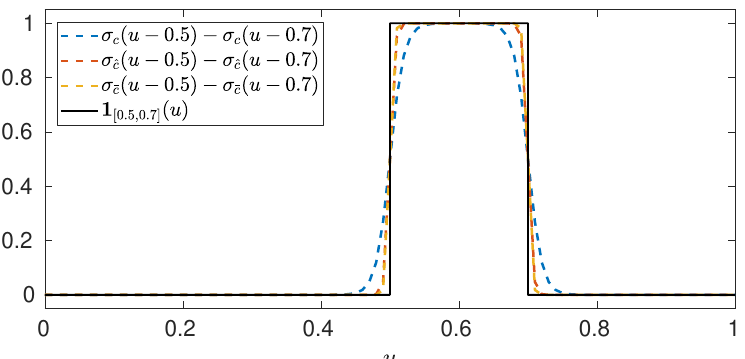
( u ) by the difference of two sigmoids. k − 1 , w k ]